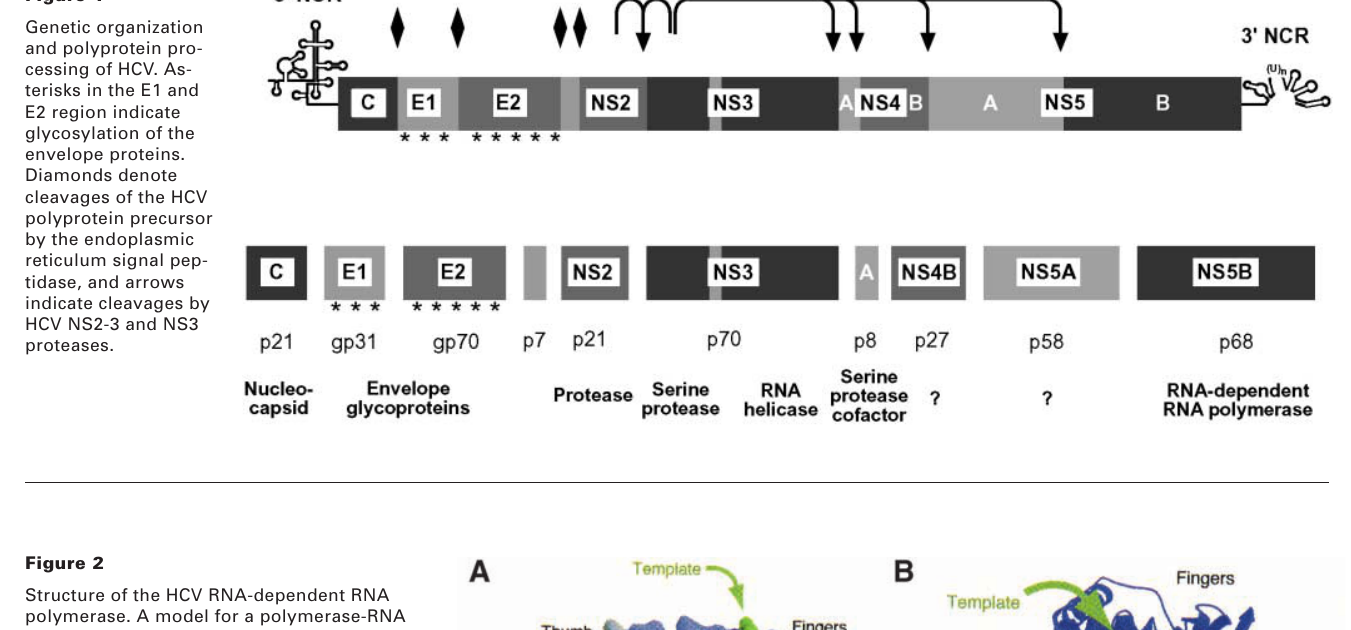
Structure of the HCV RNA-dependent RNA polymerase. A model for a polymerase-RNA template: primer-rNTP complex is shown. (A) The completely encircled pathway for access of the rNTP to the active site is shown. The mo- lecular surface is colored from blue (positive) to red (negative) according to the local electro- static surface potential. (B) Ribbon diagram with the fingers subdomain drawn in blue, the palm subdomain in red and the thumb sub- domain in green (from Lesburg CA et al. Nat Struct Biol 1999;6:937–943 with